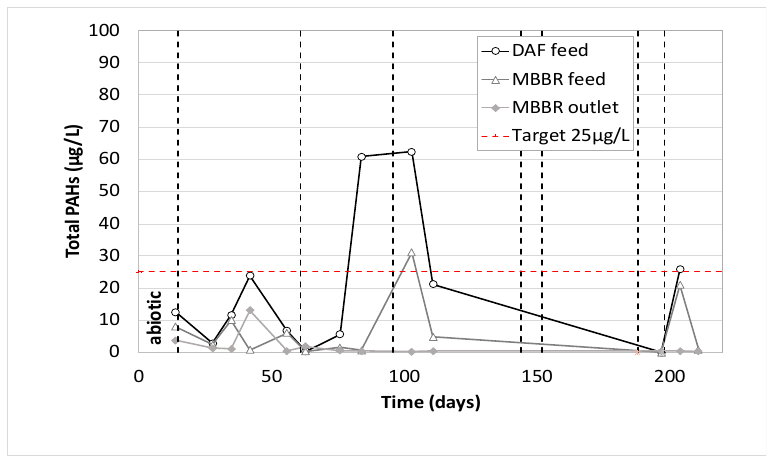
Figure 21. Total BTEX concentration along the pilot unit versus time of operation.